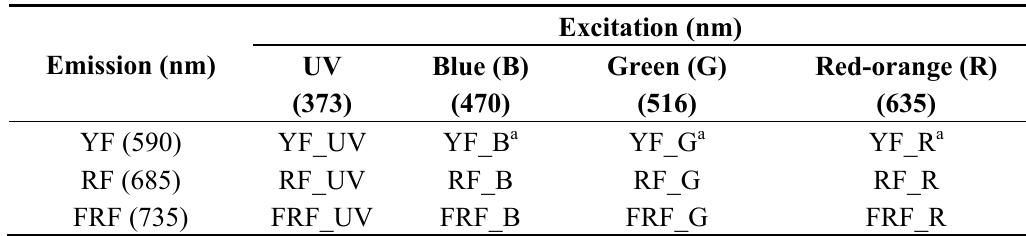
Table 1. Nomenclature of Multiplex ® signals. The name of each signal in the fluorescence excitation-emission matrix is defined by the abbreviation for its emission-light colour separated by the underscore sign from the abbreviation for its excitation-light colour: yellow (YF), red (RF) and far-red (FRF) fluorescence, excited by ultraviolet (_UV), blue (_B), green (_G) or red (_R) light. The central wavelength of each colour is indicated in brackets.